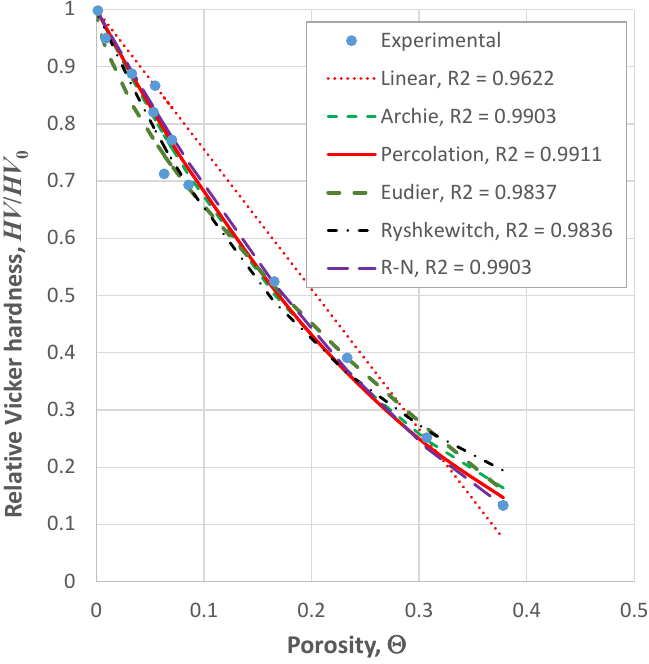
Figure 4. Experimental values of relative Vickers hardness vs. porosity [59], and fitting with the linear law, Archie’s law (Bal’shin), percolation law, Ryshkewitch’s law, Eudier’s law and Rzhevsky-Novik’s law.